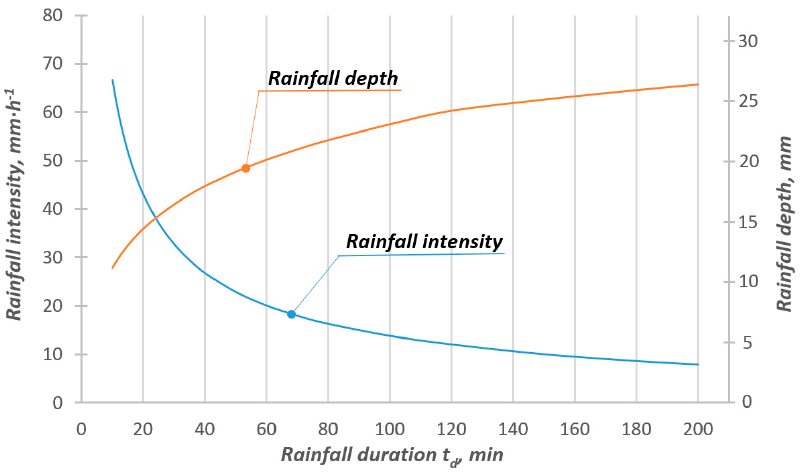
Figure 2. The IDF curve determined on the basis of the Bogdanowicz and Stachy formula.